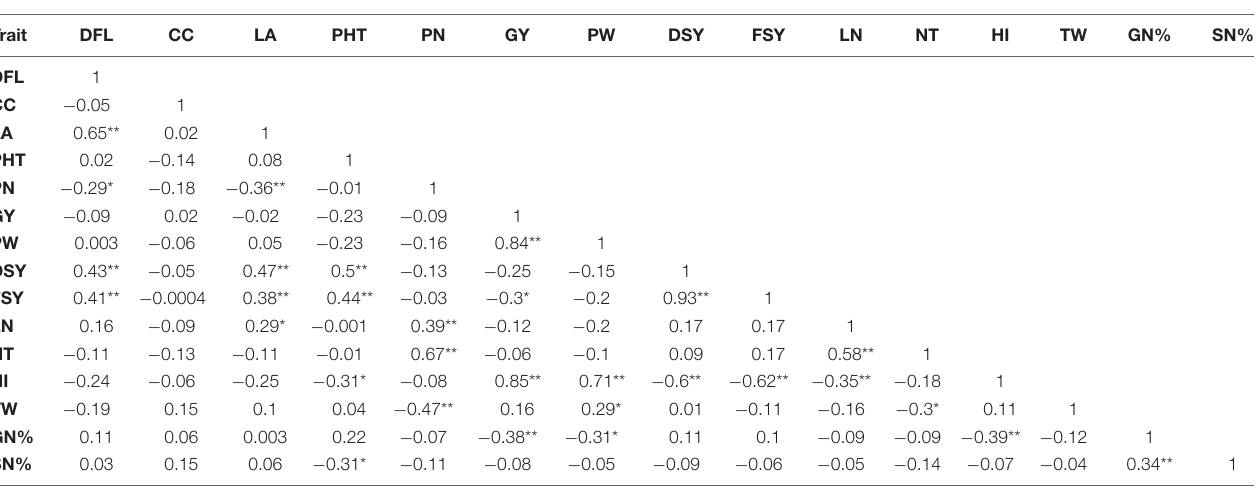
TABLE 4 | Correlation coefficient analysis of 60 genotypes for different trait at N50 condition across